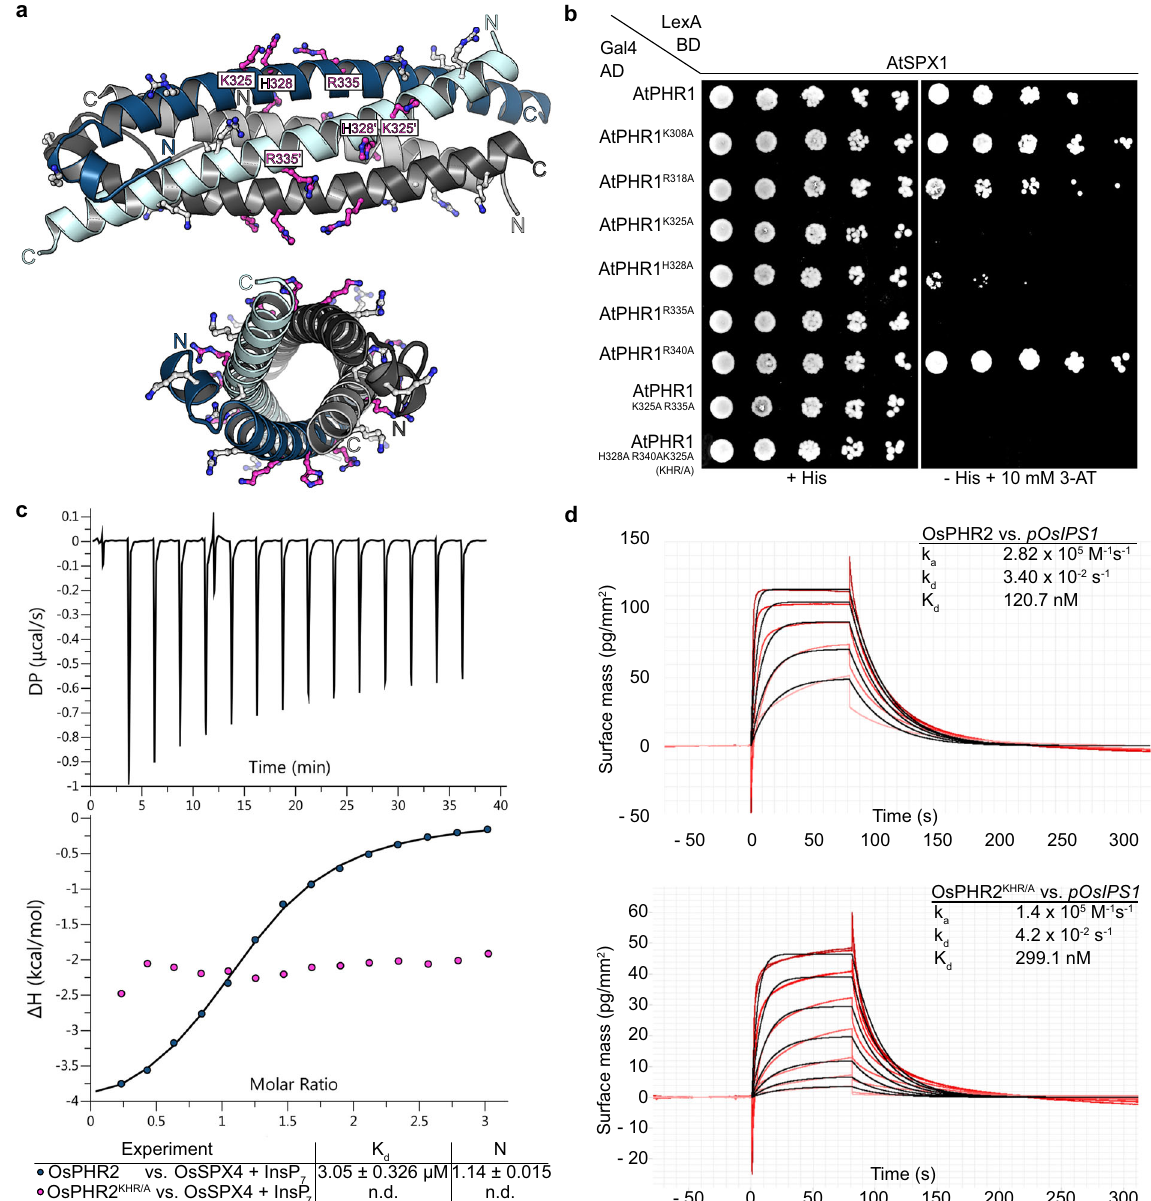
Fig. 3 The KHR motif at the surface of the PHR coiled-coil domain is required for the interaction with SPX domains. a Ribbon diagram of the AtPHR1 CC domain with conserved basic residues located at the surface of the domain shown in bonds representation. The KHR motif (AtPHR1 K325 , AtPHR1 H328 , AtPHR1 R335 ) is highlighted in magenta. b Mutational analysis of the basic residues in AtPHR1 CC. Yeast co-expressing AtPHR1 226 – 360 variants in which surface-exposed basic residues have been replaced with alanine fused to the Gal4-AD (prey) and AtSPX1 fused to the LexA-BD (bait) were grown on selective SD medium supplemented with histidine ( + His; co-transformation control) or lacking histidine and supplemented with 10 mM 3-amino-1,2,4- triazole (3-AT) ( − His + 10 mM 3-AT; interaction assay) to identify residues required for interaction with AtSPX1 in yeast two-hybrid assays. Shown are serial dilutions from lift to right. c Isothermal titration calorimetry (ITC) assay of wild-type OsPHR2 and OsPHR2 KHR/A (300 µ M) vs. OsSPX4 (20 µ M) – 5PP-InsP µ M). Raw heats per injection are shown in the top panel, the bottom panel represents the integrated heats of each injection, fi tted to a 5 (100 one-site binding model (solid line). The insets show the dissociation constant ( K D ) and binding stoichiometry ( N ) (± fi tting error, n.d. no detectable binding). d Quantitative comparison of the interaction of OsPHR2 (top panel) or OsPHR2KHR/A (bottom panel) with pOsIPS1 by GCI. Sensorgrams show raw data (red lines) and their respective fi ts (black lines). The insets show summarize association rates ( k a ), dissociation rates ( k d ), and the dissociation constant ( K d ) of the respective